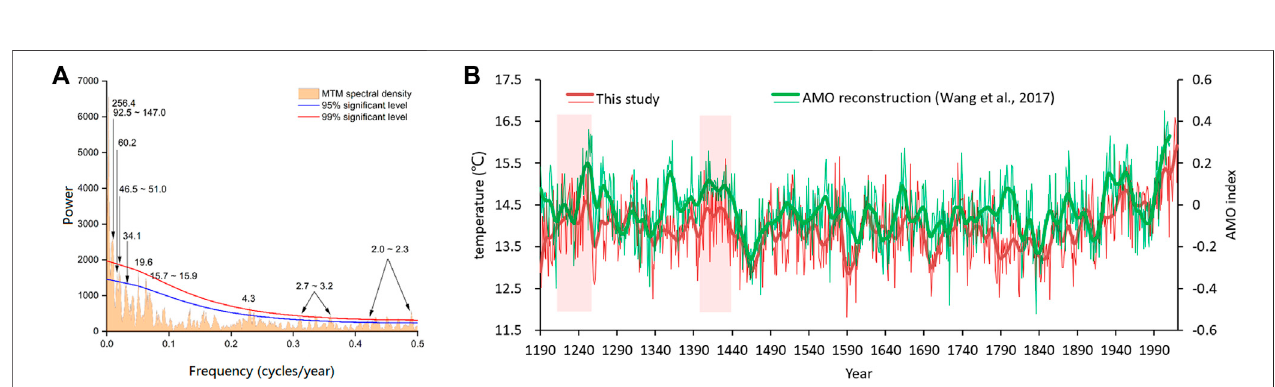
FIGURE 8 | (A) Power spectrum of June – July temperature (1190 – 2019). (B) Comparison between the reconstructed mean June – July temperature and reconstructed AMO (Wang et al., 2017) for the period 1190 – 2010. The thick lines are the 20-year low-pass fi ltered values. The boxes mark important Asian historical landmarks: Mongol conquests and the rise of Oirat